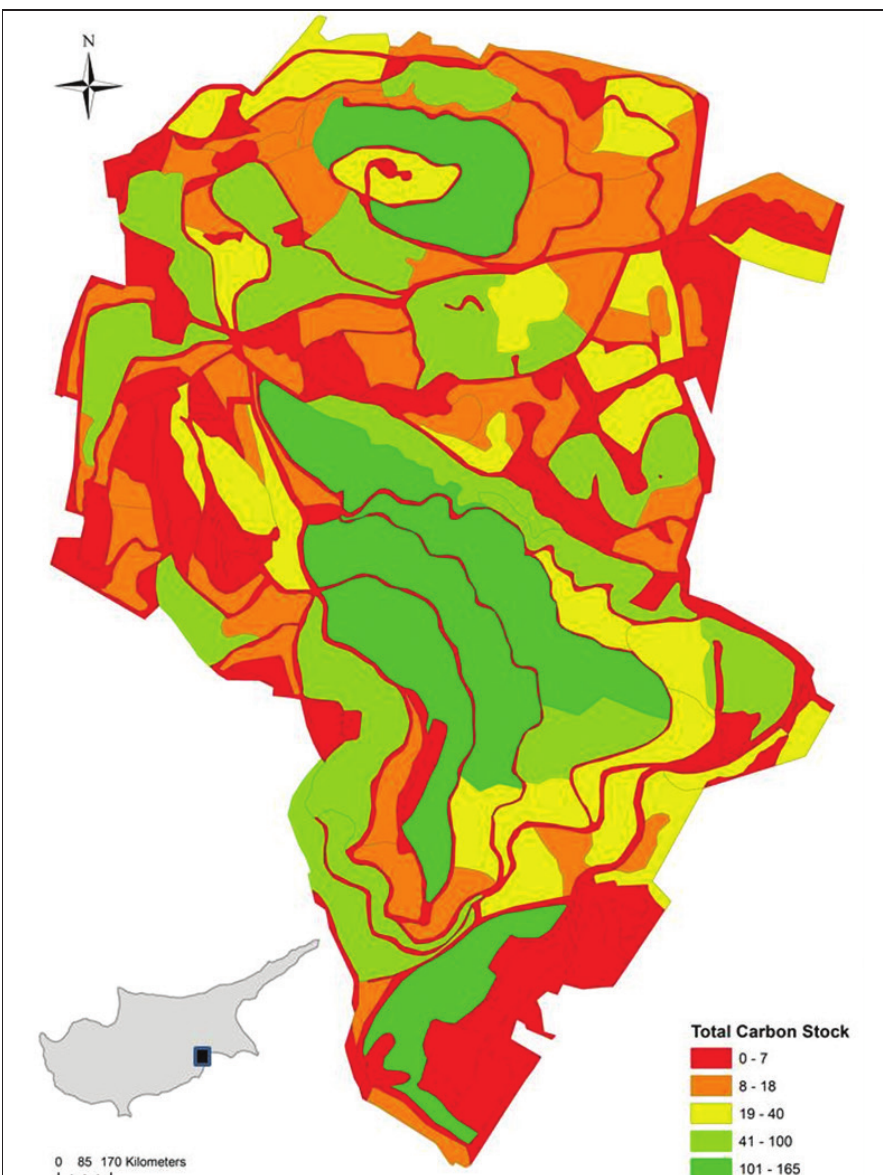
Figure 1. Location of the study area and Total Carbon Stock (tones of Carbon) derived from TESSA